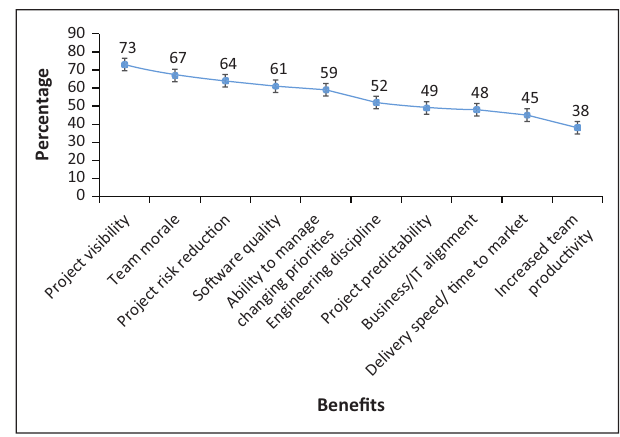
FIGURE 3: Reasons for adopting Agile methods. FIGURE 4: Benefits of adopting Agile